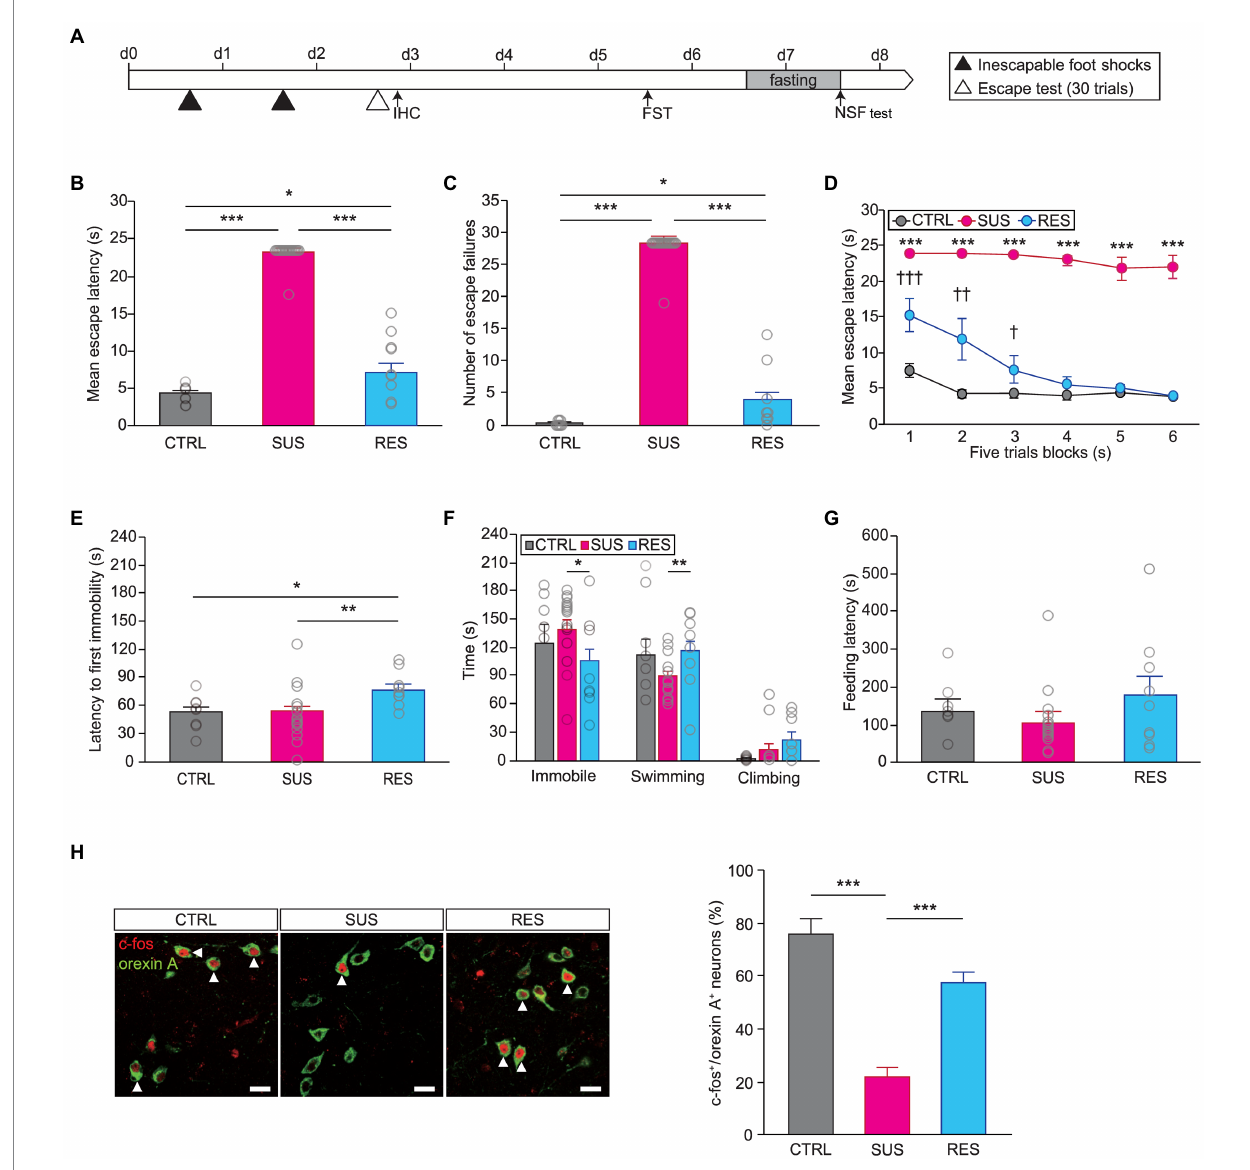
FIGURE 1 The activity of orexinergic neurons is significantly different between stress-resilient animals and susceptible animals. (A) Experimental schedule of the learned helplessness test (LHT) and other behavioral tests. A subset of animals was subjected to IHC after the first inescapable foot shock session or after the escape test [control (CTRL): n = 8, susceptible (SUS): n = 18, resilient (RES): n = 9]. (B) Susceptible mice displayed a significant delay in mean escape latency in the escape test (* p < 0.05, *** p < 0.001, Mann–Whitney U post hoc test). (C) Number of escape failures in the escape test (* p < 0.05, *** p < 0.001, Mann–Whitney U post hoc test). (D) Mean escape latency across blocks of five trials ( † p < 0.05, †† p < 0.01, ††† p < 0.001, RES vs. CTRL, least significant difference (LSD) post hoc test; *** p < 0.001, SUS vs. CTRL, LSD post hoc test). (E) The latency to first immobility in the FST was significantly longer for the RES group (* p < 0.05, ** p < 0.01, LSD post hoc test). (F) Time spent immobile, swimming, or climbing in the FST (* p < 0.05, Mann–Whitney U post hoc test; ** p < 0.01, LSD post hoc test). (G) Latency to first feeding in the novelty suppressed feeding (NSF) test. (H) Immunofluorescence staining of orexinergic neurons with c-fos revealed a significant difference between groups. Representative images of c-fos expression in orexinergic neurons in the lateral hypothalamic area (LHA) in the three groups of mice are shown on the left (CTRL, n = 3; SUS, n = 5; RES, n = 4; scale bars indicate 20 μ m). White arrowheads indicate cells double-labeled with c-fos (red) and orexin A (green). The quantitative results are shown in the graph on the right (*** p < 0.001, LSD post hoc test). In all graphs, magenta, blue, and gray indicate the susceptible group, resilient group, and non-shocked control group,